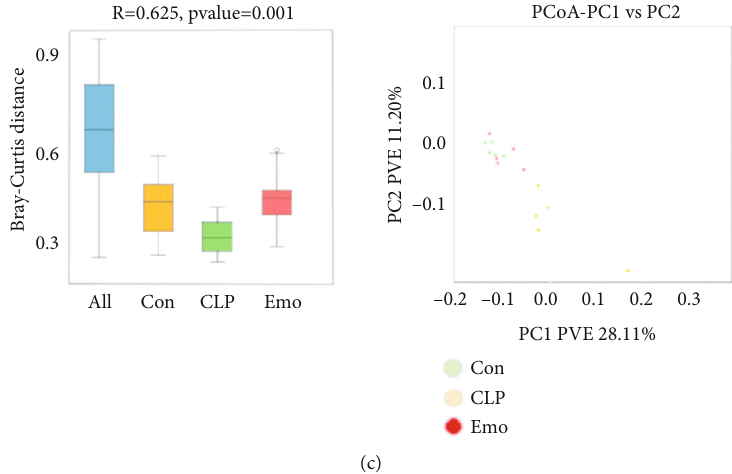
Figure 6: Emodin regulates intestinal community structure in septic mice. (a) Histogram of species distribution. The chart was the pie chart of the distribution of species at each level: including phyla, class, order, family, and genus. One color represented one specie; the length of the color block (histogram) or area of the color block (pie chart) presented the relative richness proportion of the species. Only species with top ten richness level were shown; the rest species were combined as others in the chart. (b) Alpha diversity of each treatment group. Use alpha diversity analysis to study the species diversity within a single sample. Ace, Chao1, Shannon, and Simpson indexes of each sample were statistically calculated at 97% similarity level. (c) Beta diversity of each treatment group. Beta diversity analysis was used to compare the di ff erences of species diversity between di ff erent samples, using Bray-Curtis based PCoA and anosim